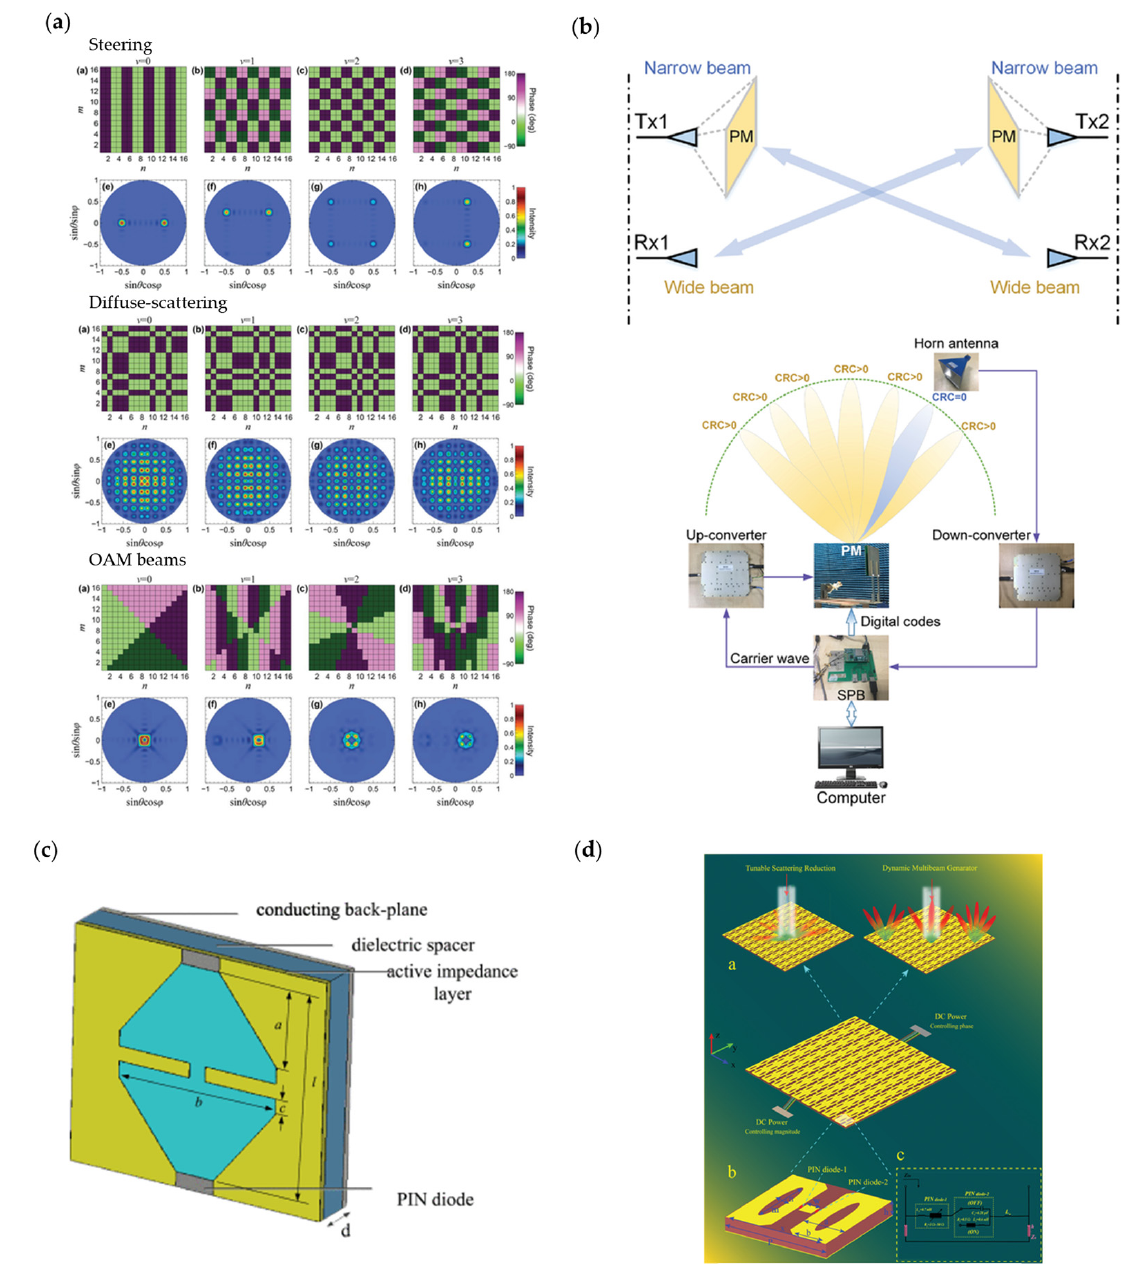
Figure 8. ( a ) Space–time coding metasurface operating at 4 different harmonics. Reprinted with per-